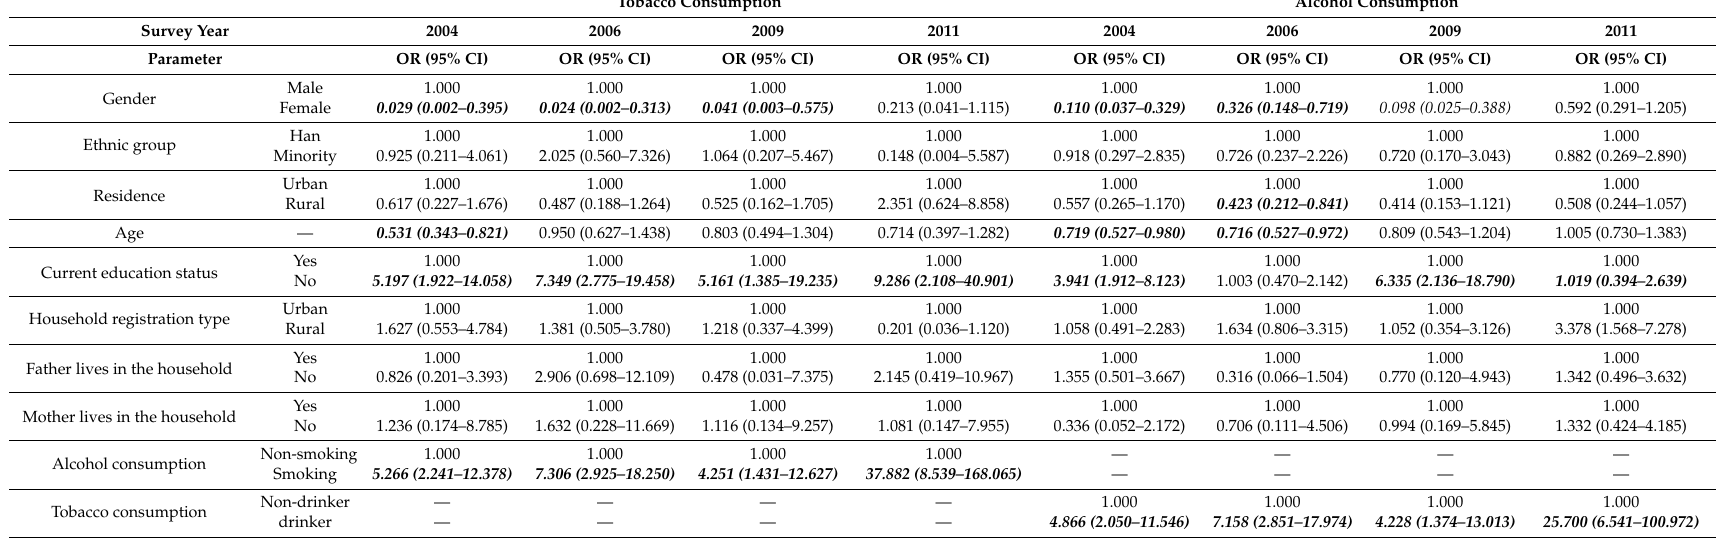
Table 5. Penalized logistic regression for tobacco consumption and alcohol consumption among Chinese adolescents (from 15–18 years old), CHNS a